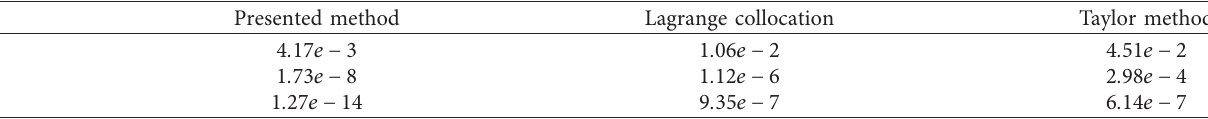
Table 5: Effect of the refinement level J and multiplicity parameter r on L